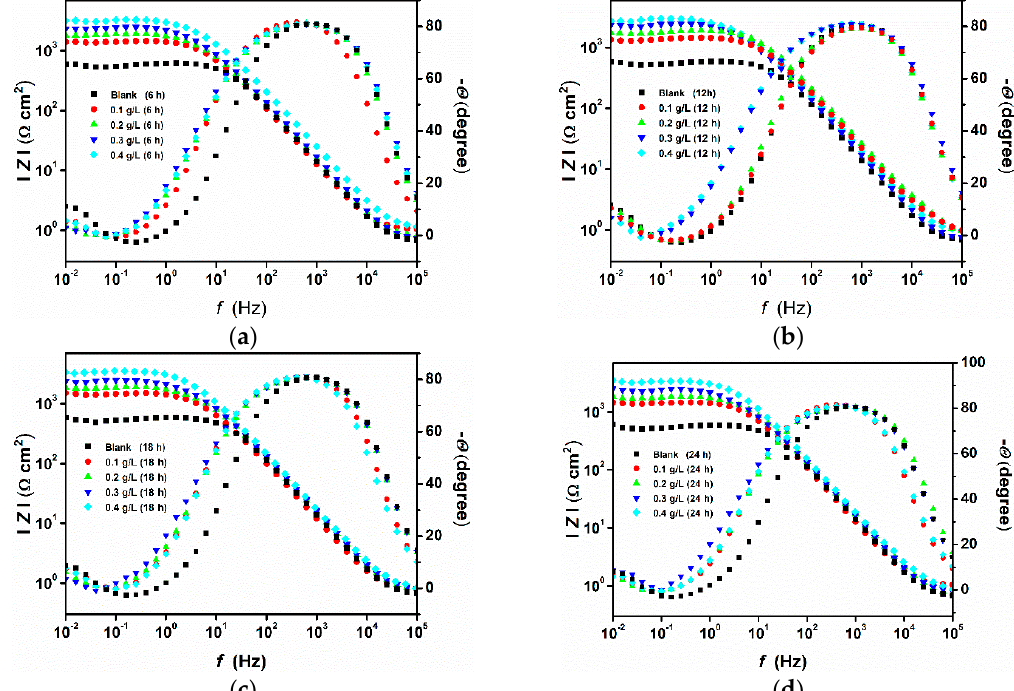
Figure 4. Nyquist plots recorded at open circuit potentials for pure aluminium in 1-M HCl without and with the addition of different concentrations of GG at 25 °C after 6 (a) , 12 (b) , 18 (c) , and 24 (d) h of immersion in the absence and presence of different concentrations of the GG.